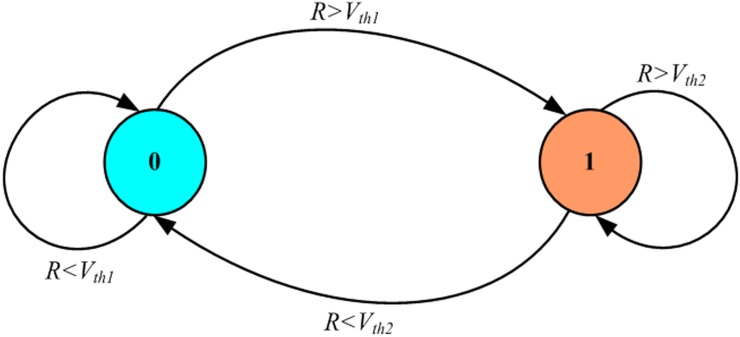
Analysis of the channel state.